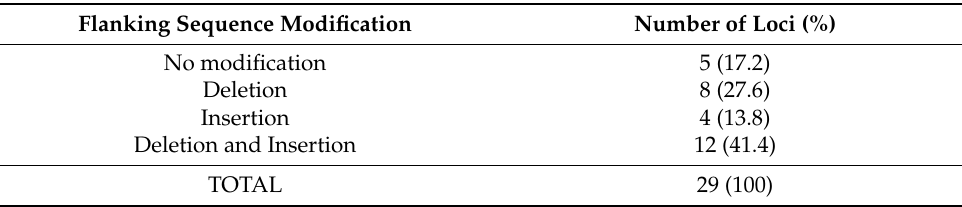
Figure 2. Phylogenetic tree of vertebrates showing species in which TERC-ITSs or empty orthologs were identified. For each species, loci are indicated on the right using the locus number reported in Table 1. Numbers in green indicate loci containing a TERC-ITS. Numbers in red indicate orthologous empty loci. Numbers in black indicate TERC-ITS loci for which no empty orthologs were identified. Where an orthologous locus was not found in a reference genome, its number is not reported. Table 2. Flanking sequence modifications at TERC-ITS